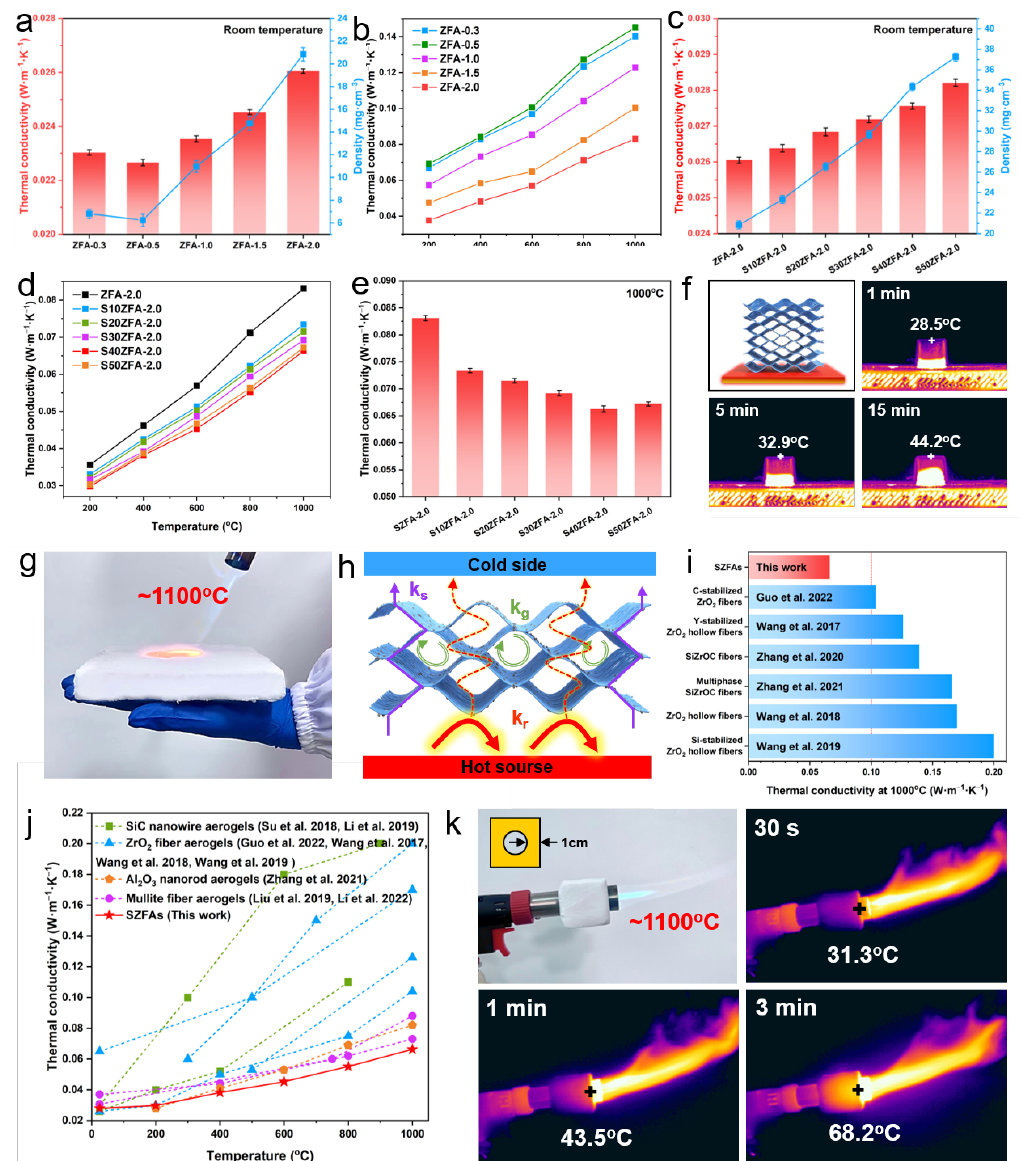
Figure 7. ( a ) Density and room temperature thermal conductivity as well as ( b ) high-temperature thermal conductivity of ZFAs with different fiber contents. ( c ) Density and room temperature thermal conductivity as well as ( d , e ) high-temperature thermal conductivity of SZFAs with different SiC contents. ( f ) Hot table heating experiment of S50ZFA-2.0 (300 ◦ C). ( g ) Superior thermal insulation performance of S40ZFA-2.0 for protecting a hand (heated for 1 min) from damage under 1100 ◦ C flame. ( h ) Schematic of high-temperature superinsulation mechanism of S50ZFA-2.0. ( i ) Comparison of high-temperature thermal conductivity of SZFAs with the reported ZrO 2 -based fiber aerogels